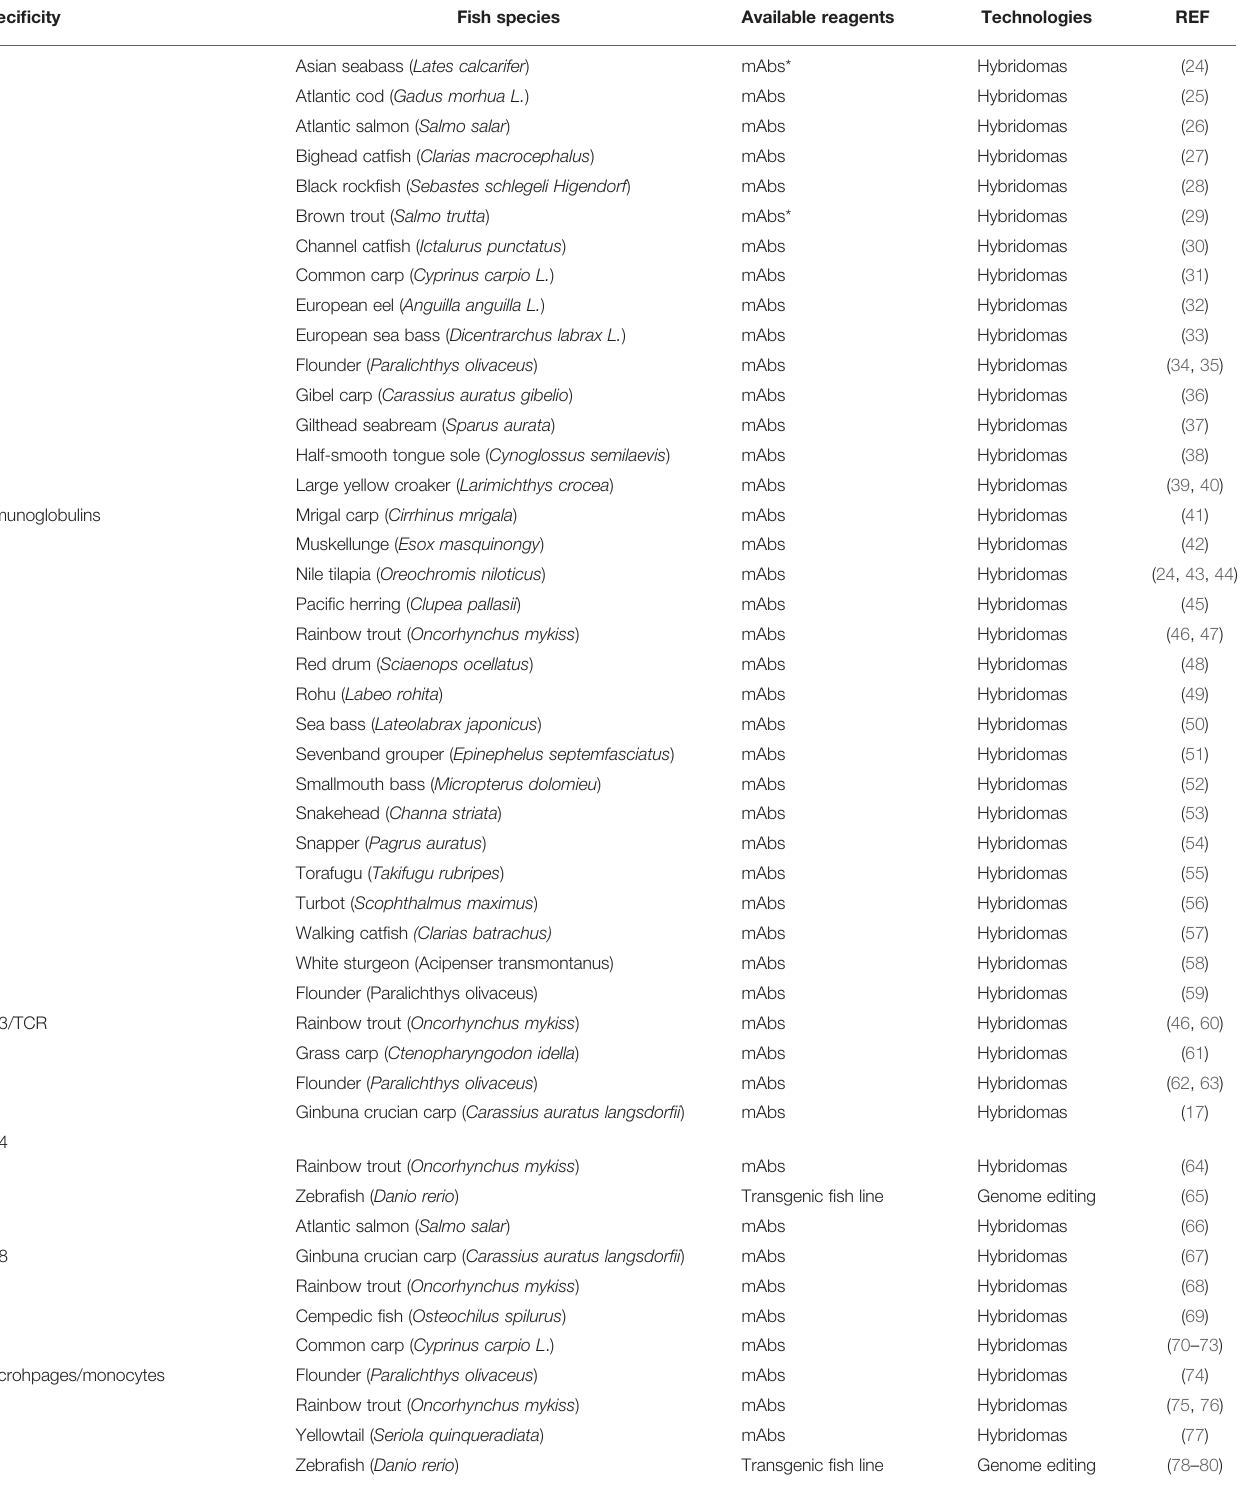
TABLE 1 | An overview of available reagents targeting surface markers/immune cells in teleost fi sh. Speci fi